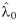
Comparison between real and estimated infectivity in simulations.Real infectivity λ0 and estimated infectivity λ^0 computed from simulation data according to Eq 2 without considering the decay effects. The solid line is the linear regression fit. Estimates are calculated from only the first 50 retweets of each tweet, so that they may be used to try to predict whether a given cascade “goes viral”.